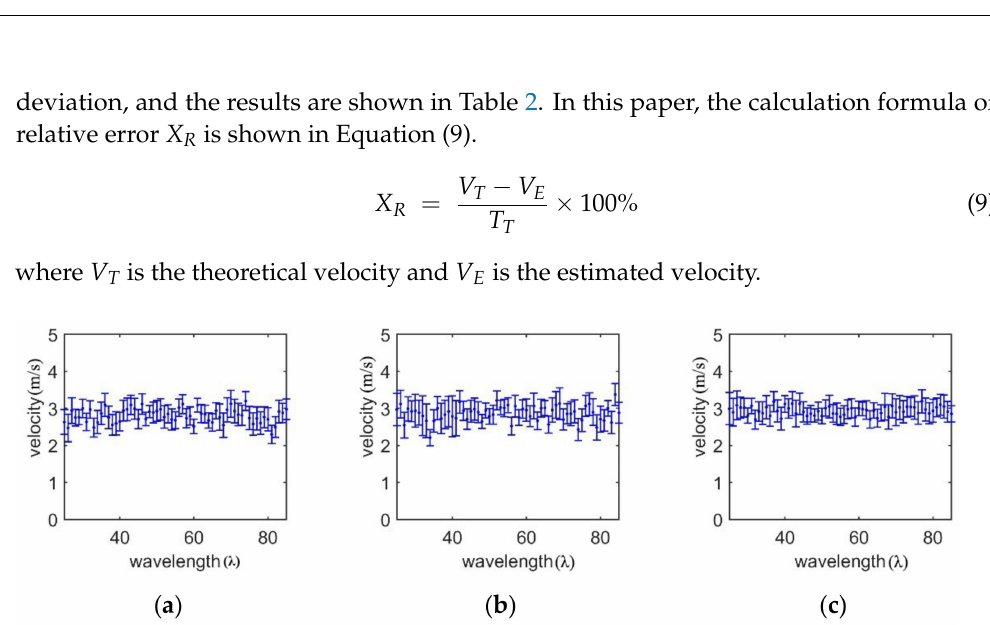
Figure 9. Velocity estimation in homogeneous region. ( a ) The time-to-peak method. ( b ) The lateral peak method. ( c ) The real-time curve tracing method. Table 2. Comparison of shear wave velocity estimation.